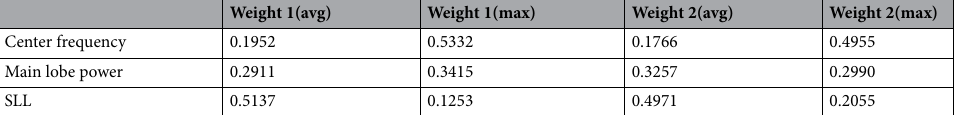
Table 3. Weight differences between average difficulty and max difficulty. For the two generations of population, the weight of sidelobe level in maximum reference value is significantly lower than that in average reference value. This result matches the prediction of the Delphi